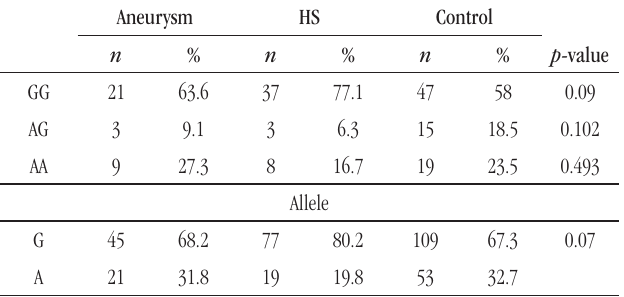
taBLE 1 − Association of TNFA -308G/A (rs1800629) polymorphism with HS or